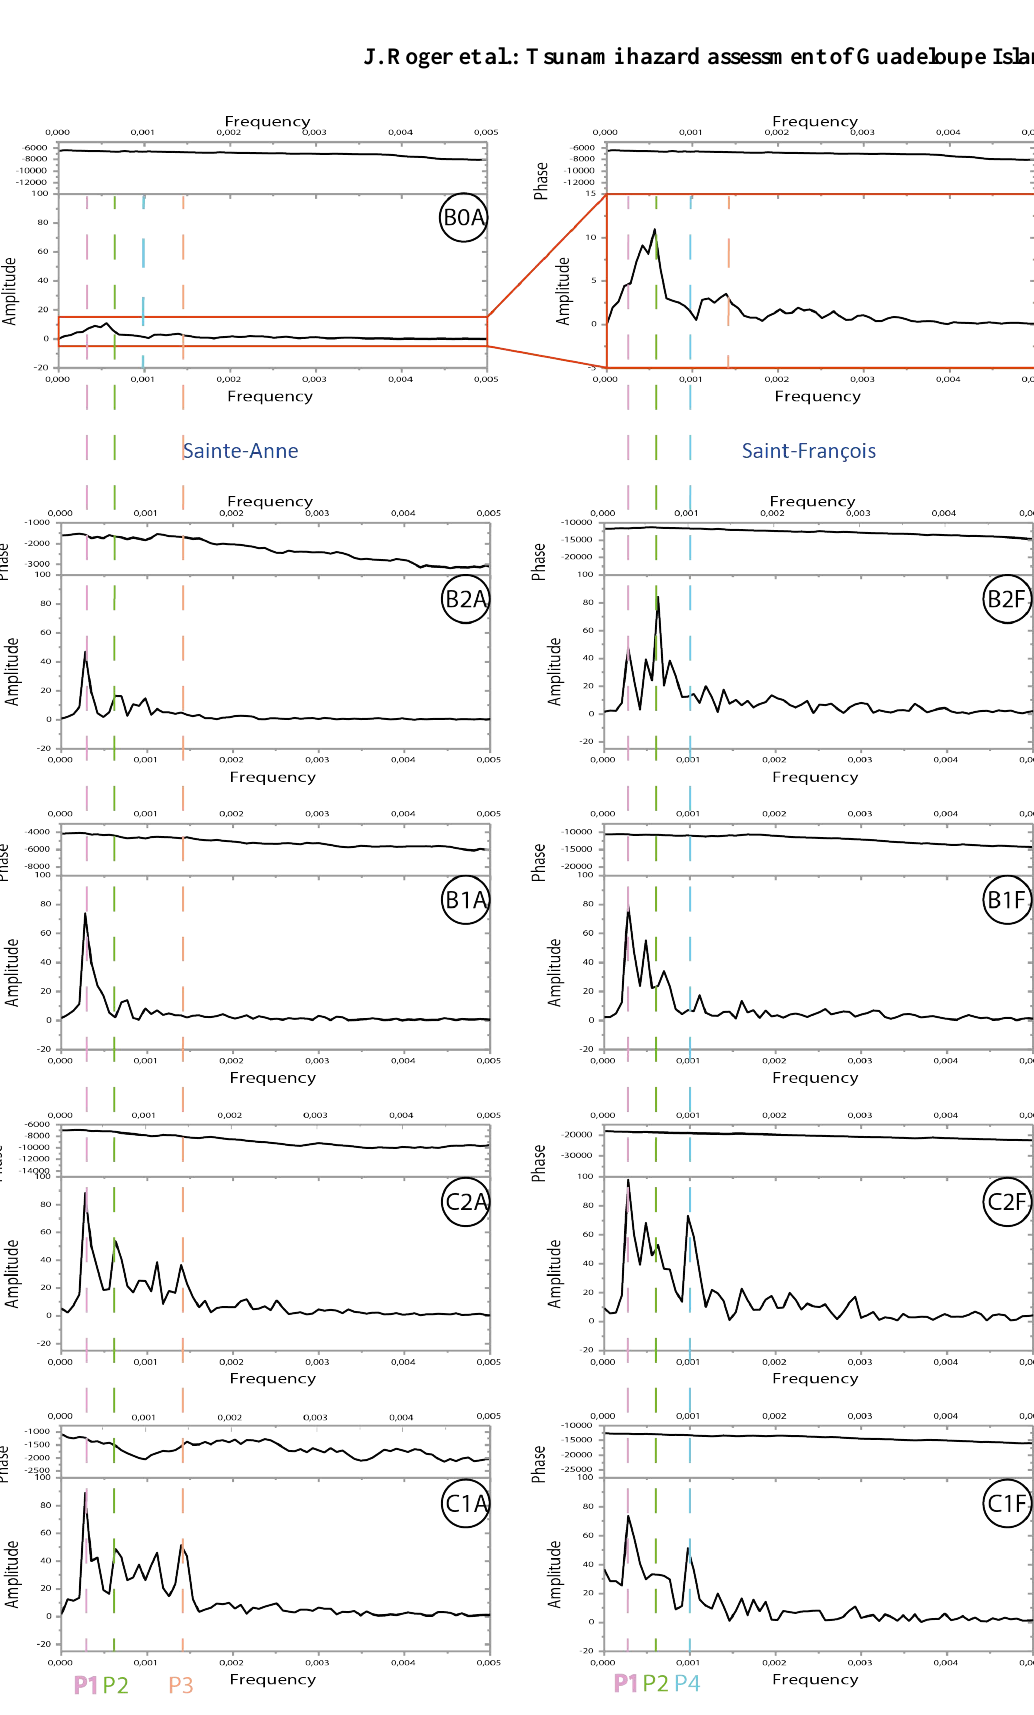
Fig. 12. (e) Frequency analysis of synthetic tide gage signals located on the tsunami path from the source area towards Sainte-Anne (left column) and Saint-Franc¸ois (right column). Main frequency peaks are indicated by P1, P2, P3 and